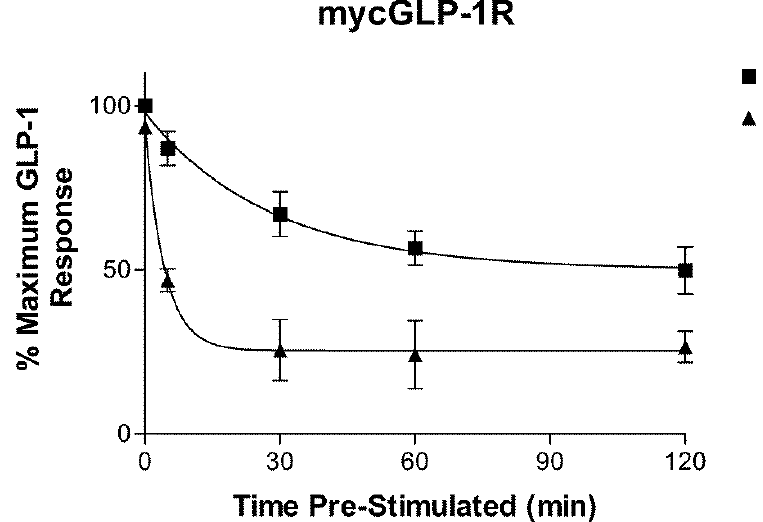
Figure 3. Rate of desensitization of mycGLP-1R. Two rates of desensitization were calculated. Apparent loss represents the loss of response to 1 µM GLP-1 following pre-incubation with 1 µM GLP-1. Net loss represents the loss of response to GLP-1 minus the non-stimulated control following pre-incubation with GLP-1. Data are expressed as a percentage of maximum GLP-1 response and represent the mean, with the S.E.M. displayed as error bars from three independent experiments.